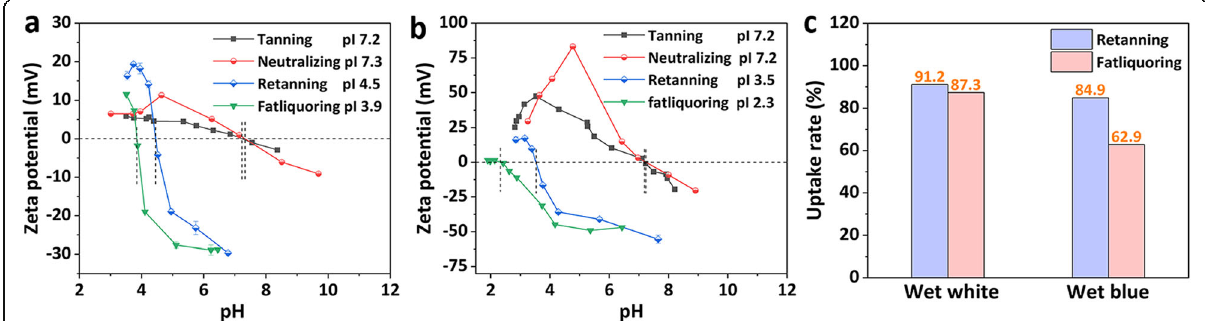
Fig. 1 pIs of wet white ( a ) and wet blue ( b ) in post-tanning processes; ( c ) uptake rates of retanning agents and fatliquoring agents in wet white and wet